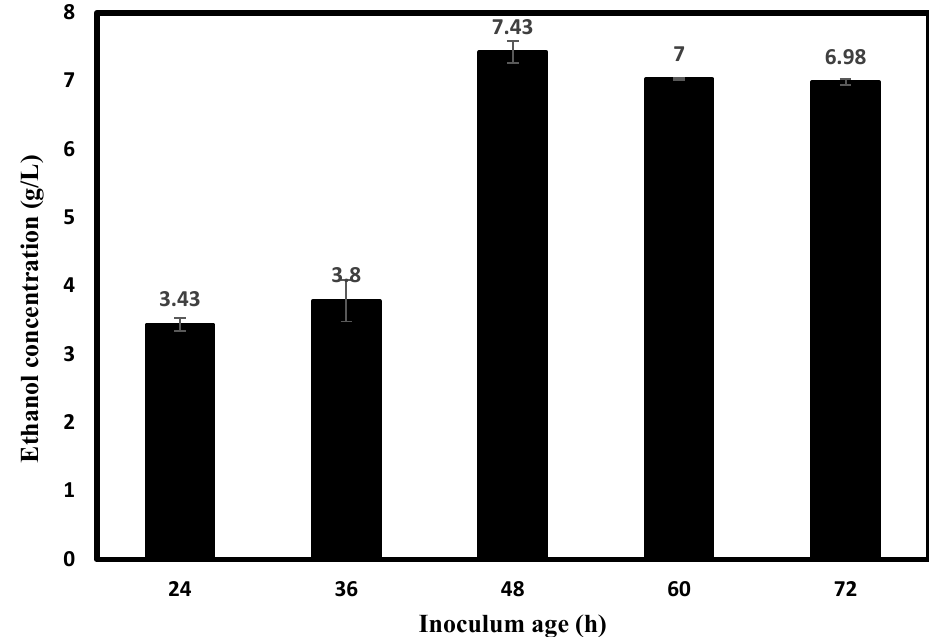
Figure 4. Effect of inoculum age on ethanol production from chitin oligomers by M. circinelloides.